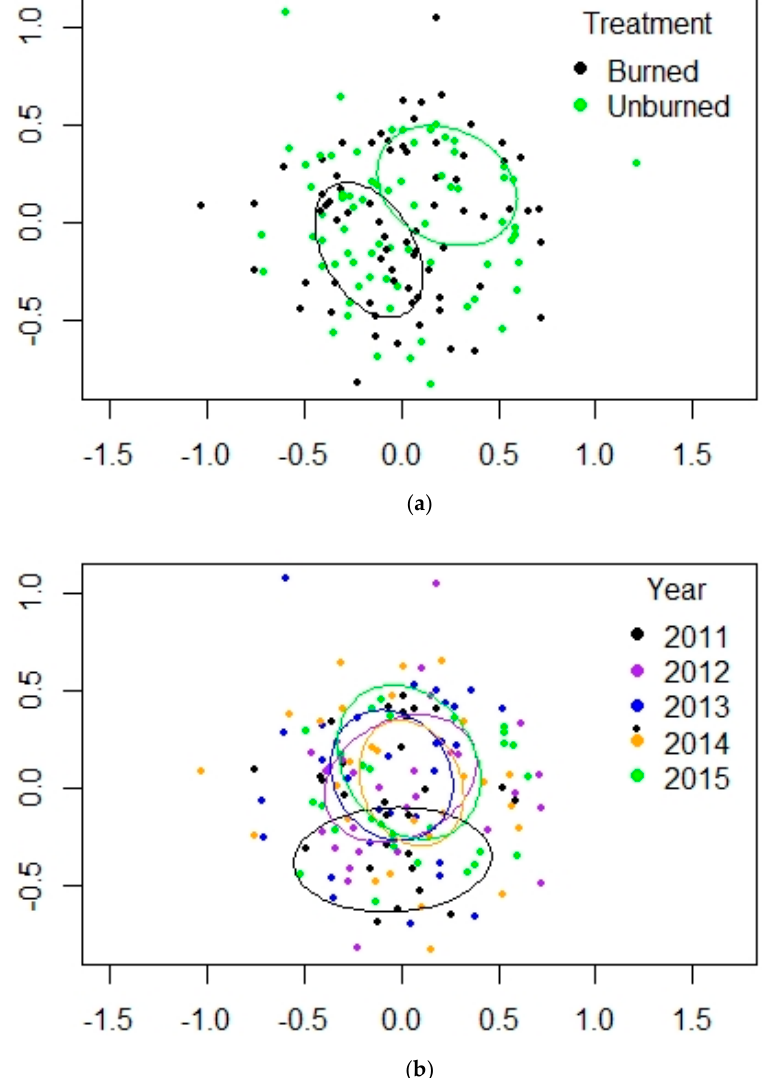
Figure 5. ( a , b ). NMDS plots for PERMANOVA results for mixed-conifer forest at Valles Caldera. ( a ) treatment, ( b ) year. Ellipses are the 95% confidence intervals for the locations of the centroids.